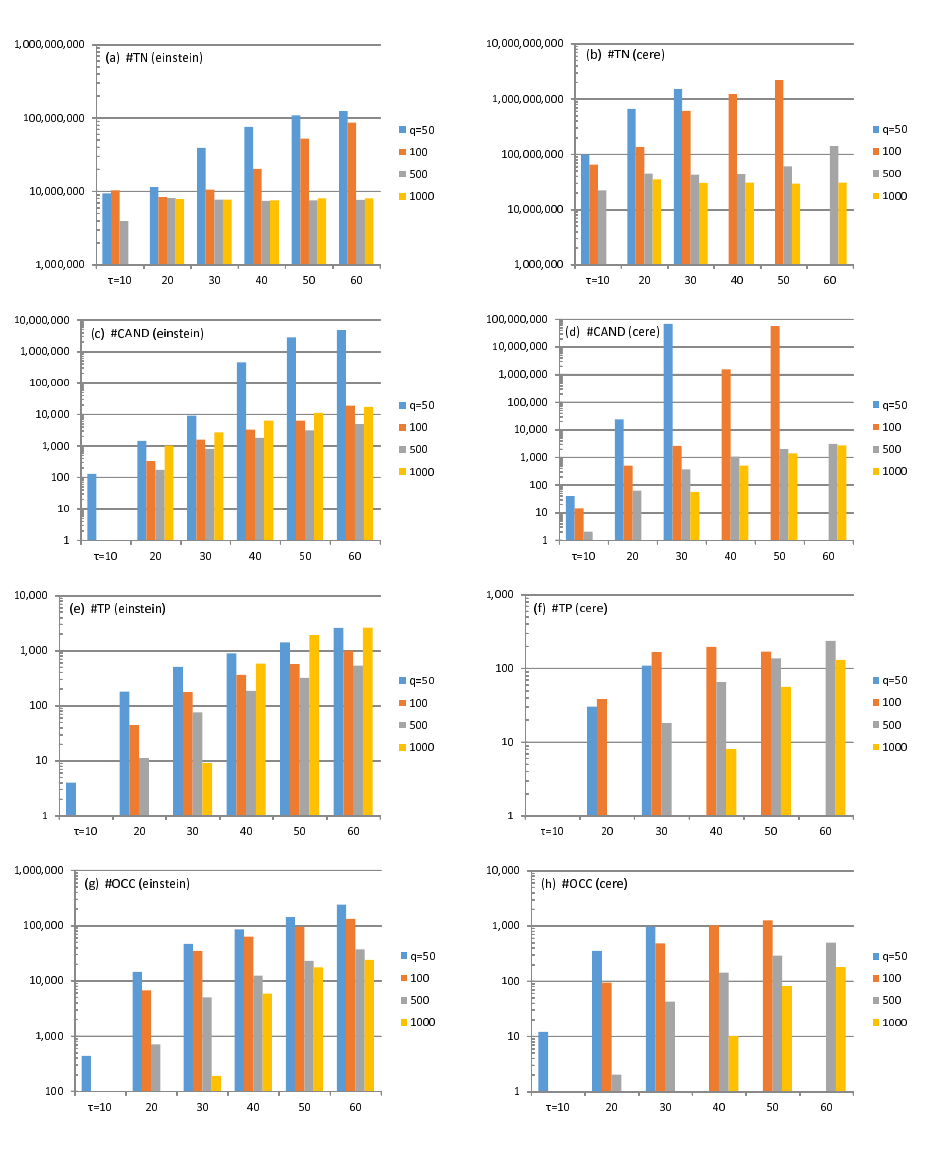
Figure 7. Statistical information of the query search: the number of traversed nodes, #TN, the number of candidate | Q | -grams, #CAND, the number of true positives, #TP, the number of occurrences, #OCC. ( a ) and ( b ) correspond to #TN, ( c ) and ( d ) correspond to #CAND, ( e ) and ( f ) correspond to #TP, and ( g ) and ( h ) correspond to #TP of einstein and cere,